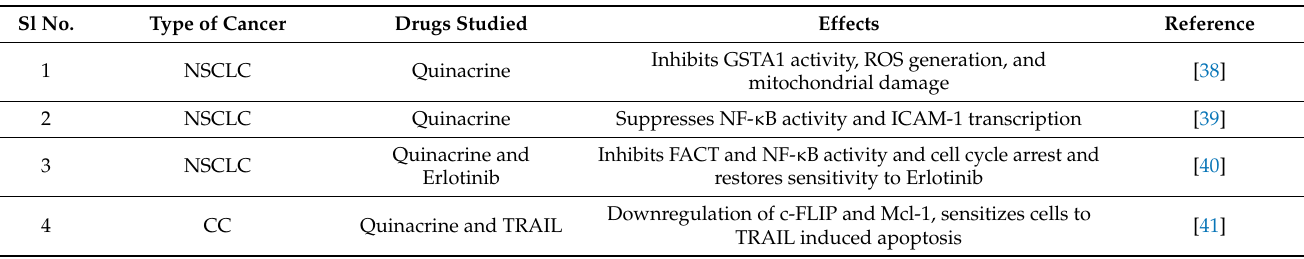
Table 1. Table summarizing the effect of QC studied on various types of cancers. NSCLC—Non- small Cell Lung Cancer, CC—Colon Cancer, ATC—Anaplastic Thyroid Cancer,